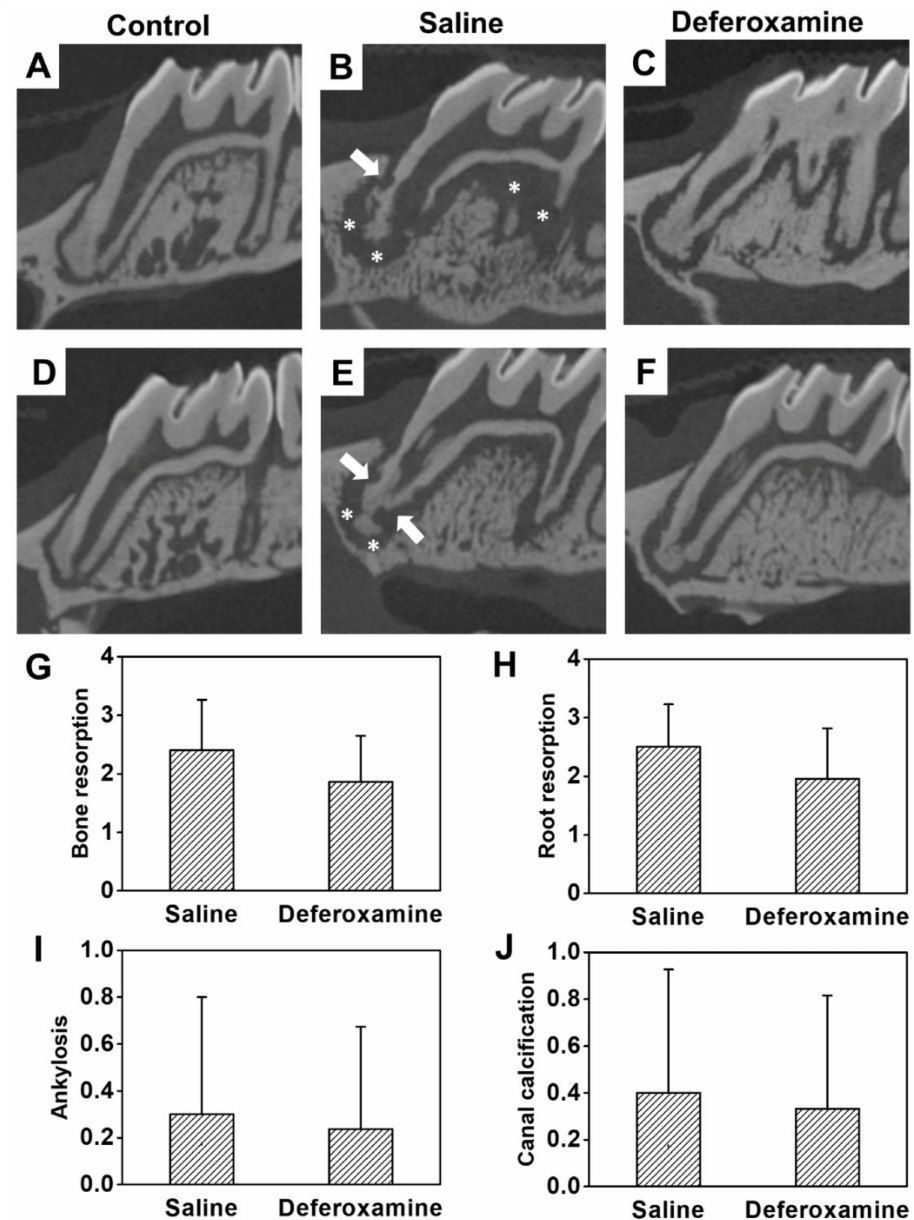
Figure 4. Micro-computed tomography images of rat maxillary first molars 4 weeks after replantation. ( A , D ) Control groups: The teeth without extraction and replantation. Normal root surface and alveolar socket. ( B , E ) Saline groups: Before replantation, 0.9% physiological saline was applied to the extracted teeth surface and alveolar socket. Severe root resorption (arrows) and extensive alveolar bone resorption (asterisks) were observed. ( C , F ) DFO groups: 500 µ M DFO solution was applied to the surface of the extracted teeth and alveolar socket. A relatively short range of bone resorption (asterisk) was observed compared to that in the saline groups. ( G – J ) Evaluated scores, represented as mean ± standard deviation, for ( G ) bone resorption, ( H ) root resorption, ( I ) ankylosis, and ( J ) canal calcification in the saline and DFO groups. However, there was no statistically significant difference between the saline and DFO